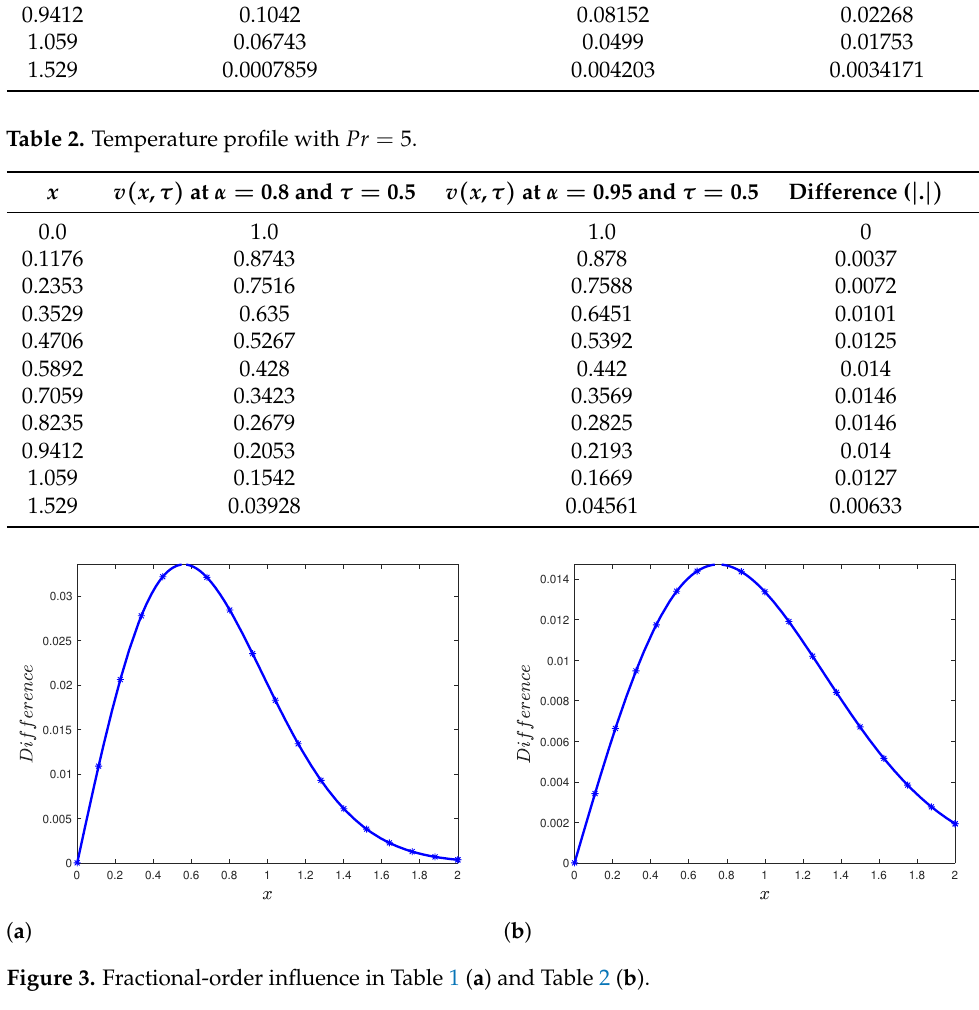
Figure 3. Fractional-order influence in Table 1 ( a ) and Table 2 ( b